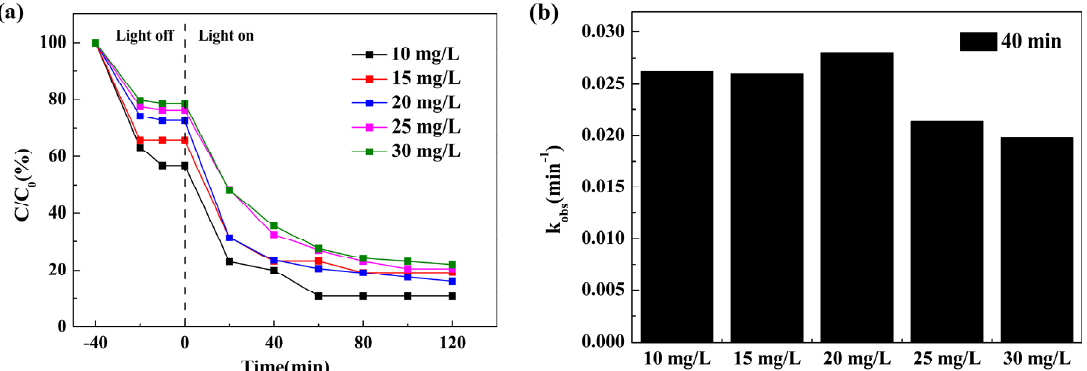
Figure 9. ( a ) Photocatalytic degradation, ( b ) rate constant of different concentrations of TC on the novel visible light driven photocatalytic system (0.320 g/L 80ZIS/CN).